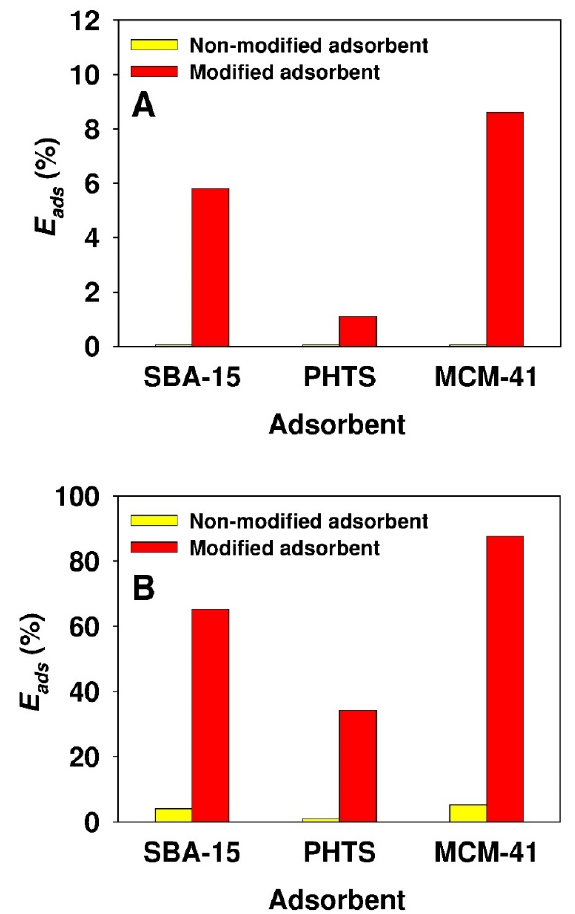
Figure 4. Comparison of ticagrelor adsorption efficiency in ( A ) 2‐propanol and ( B ) acetonitrile onto nonmodified and propyl‐sulfonic acid‐modified mesoporous silicas. Initial ticagrelor concentration C 0 = 2000 mg/dm 3